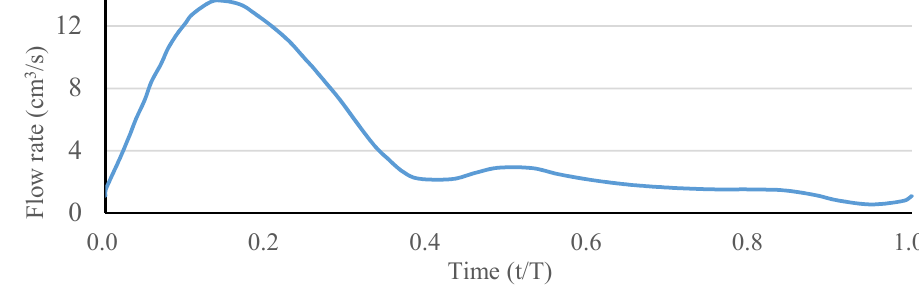
Figure 3. Waveform of the inlet blood flow rate in a single pulse.